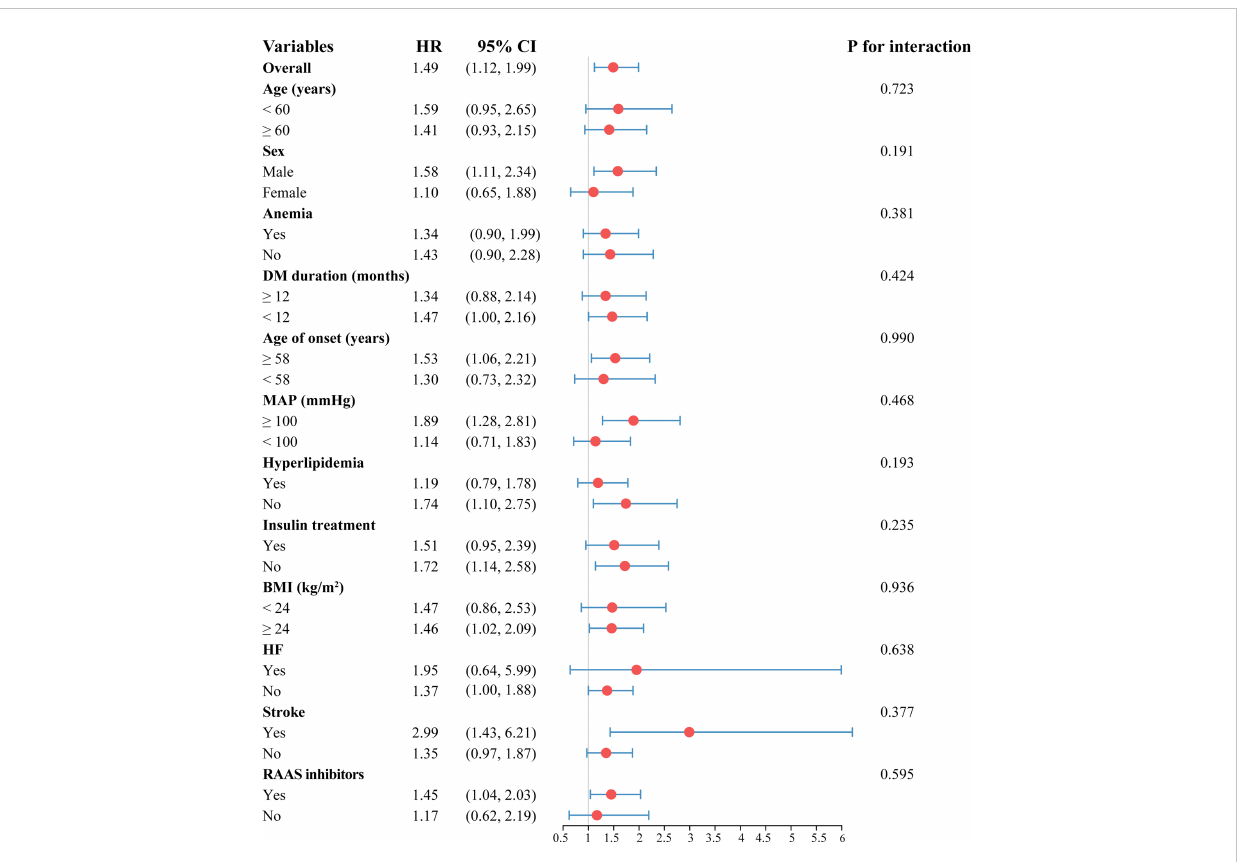
FIGURE 4 Subgroup analysis of the association between baseline TyG index and ESRD